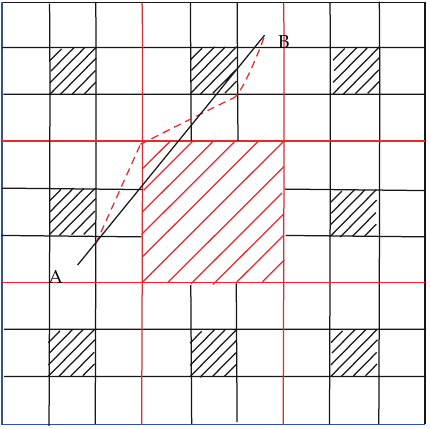
Figure 7: The distance between two points in a discontinuous